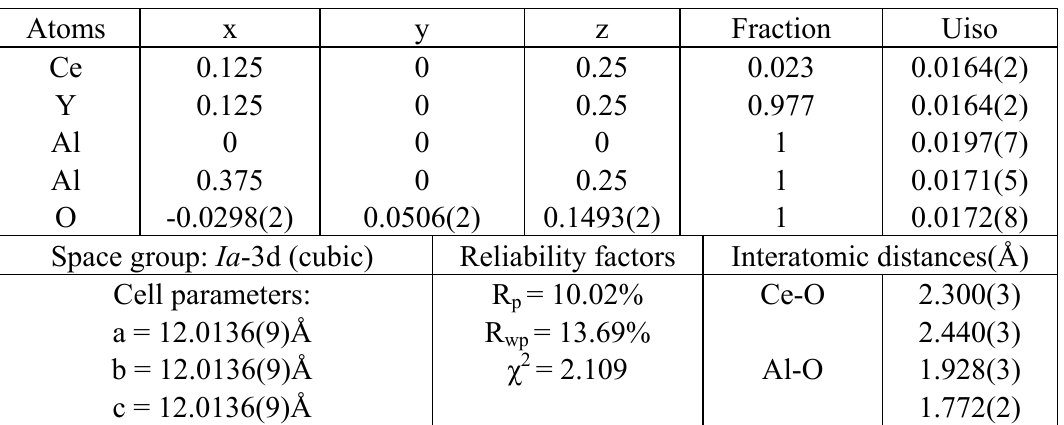
Ce )Al O 2.93 0.07 5 12